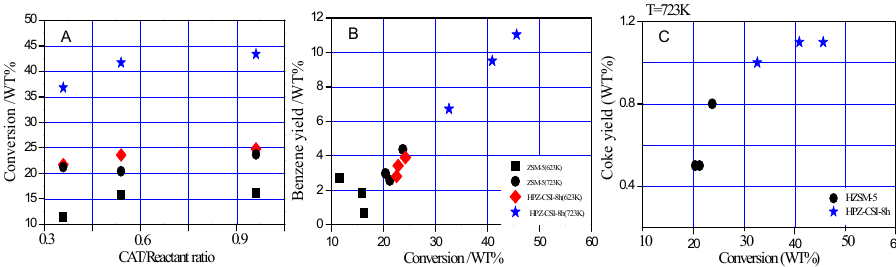
Figure 5. ( A ) Conversion and ( C ) coke yield of 1,3,5-triisopropylbenzene (TIPB) cracking reactions and ( B ) the benzene yields (wt %) for TIPB cracking reactions at 623 K, 723 K, and 70 s time on stream over the HZSM-5 ( ■ 623 K, ● 723 K) and HPZ-CSI-8h ( ◆ 623 K, ★ 723 K) zeolites. Table 2. Conversion, yield, selectivity, and rate constants ( k TIPB ) from the TIPB catalytic cracking at 623 K, 723 K, and 70 s time on stream over the HPZ-CSI-8h zeolites.